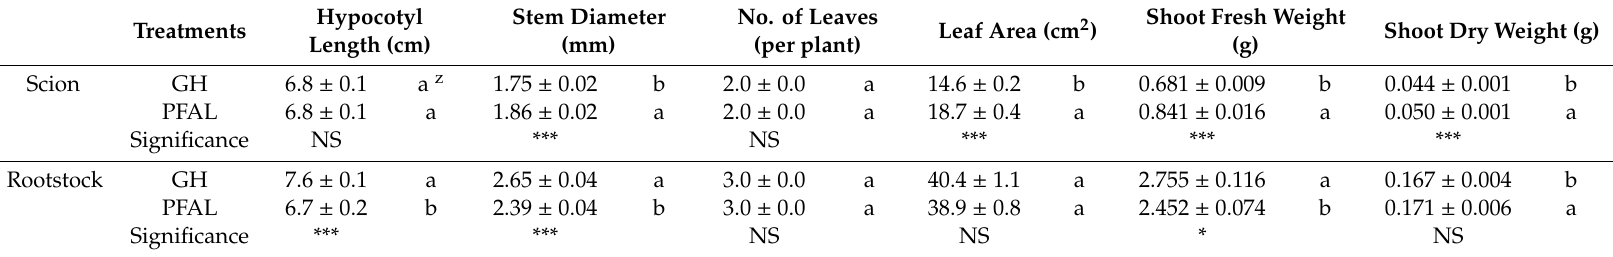
Table 5. Hypocotyl length, stem diameter, number of leaves, leaf area, shoot fresh and dry weight of cucumber scion and rootstock cultivated in a PFAL and GH ( n = 7, R = 3).